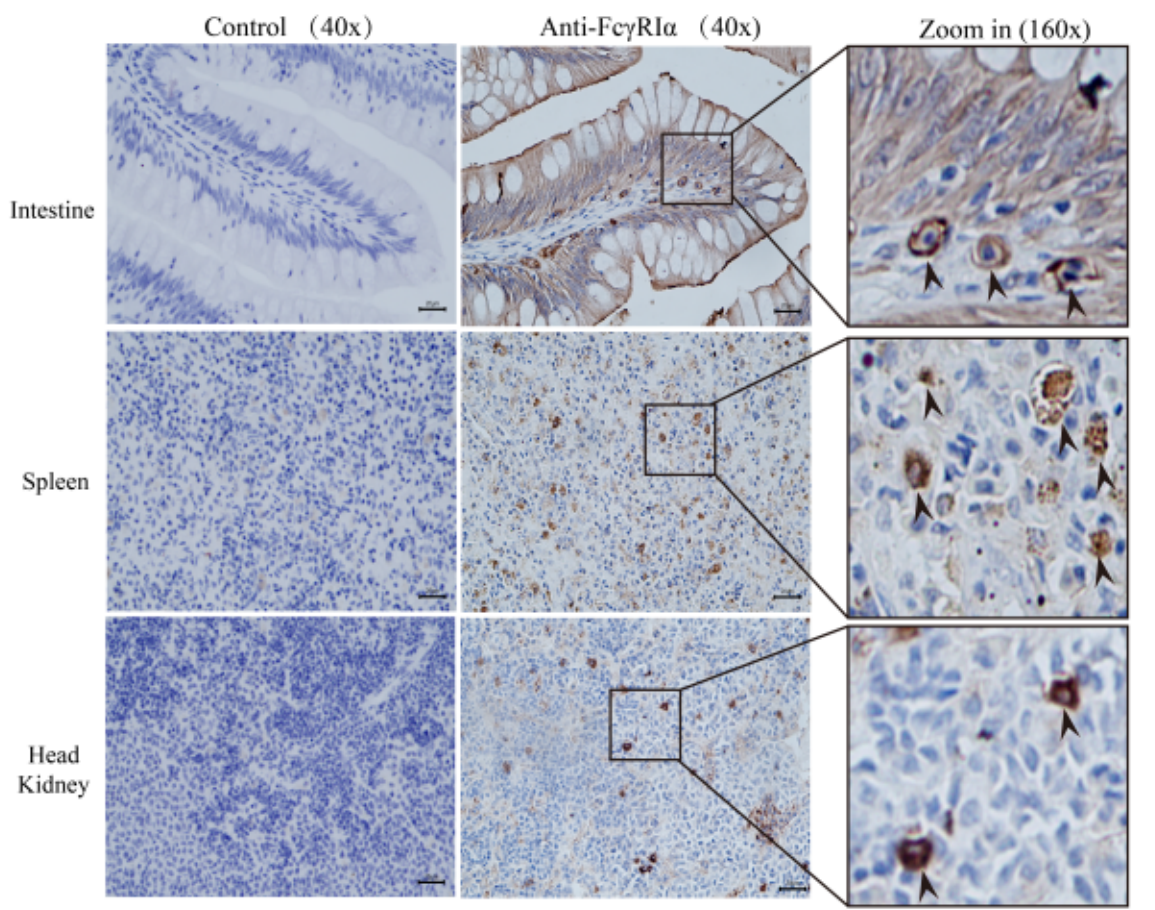
Figure 5. Secretory MsFc γ RI α expression in largemouth bass tissues by IHC. The brown sediment suggests the presence of MsFc γ RI α . Strongly positive signals (+++) are shown with arrows in the intestine, spleen, and head kidney, and no signal in the negative control. Positive signals are found among the cytoplasm in these three tissues. IHC results indicate that MsFc γ RI α is secretory. IHC results are shown at 40× and 160× magnification. Scale bar = 20 µm.